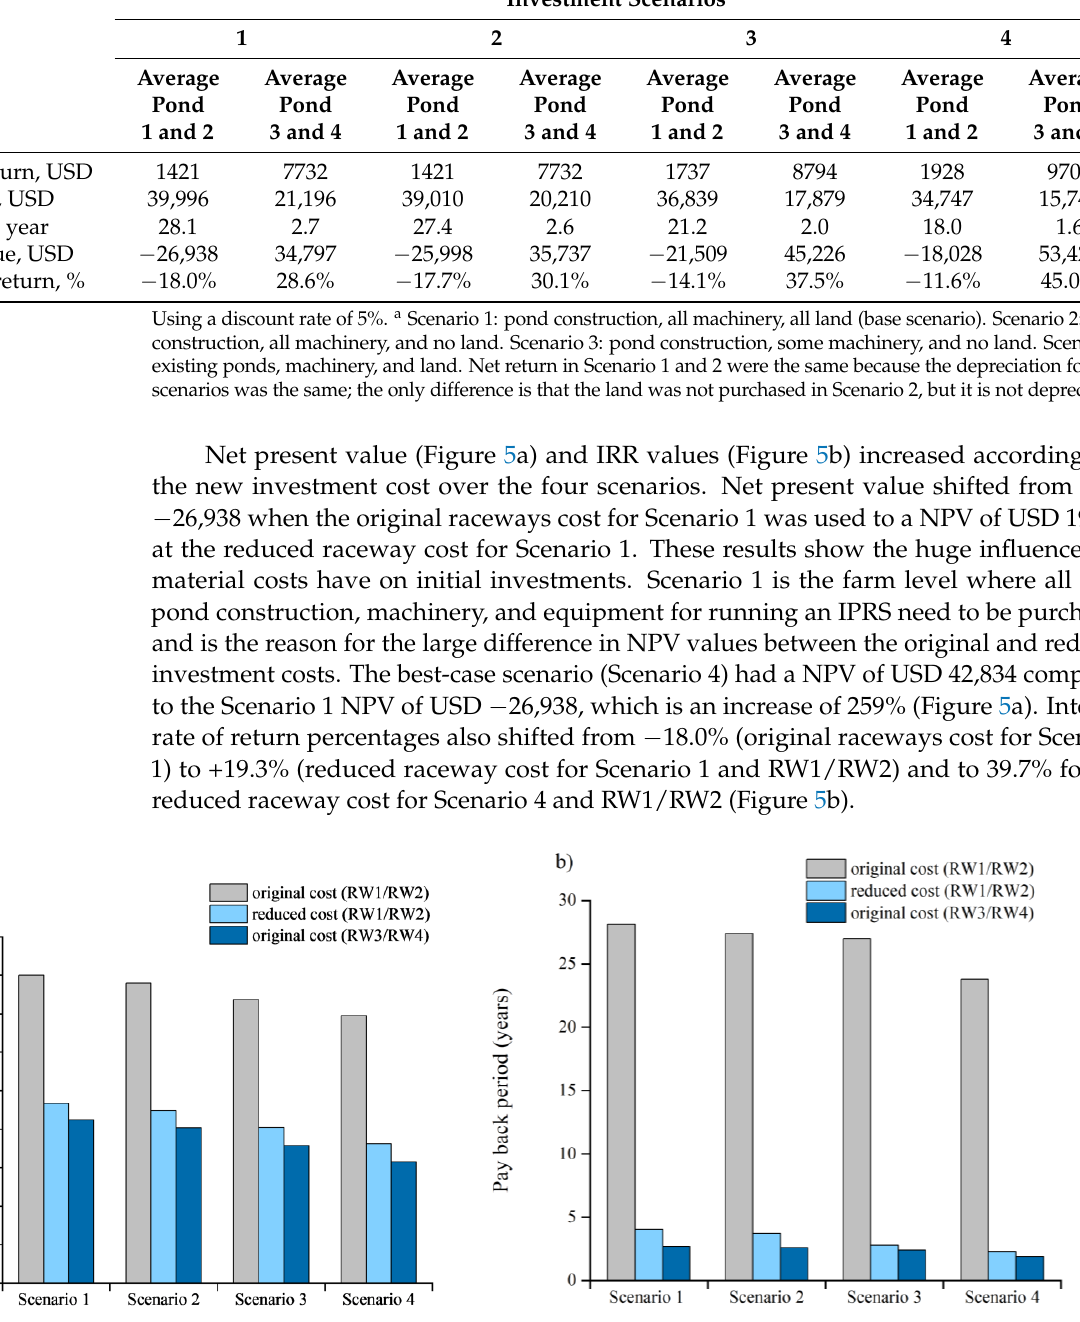
× blue catfish, I. furcatus , in in-pond ♀ ♂